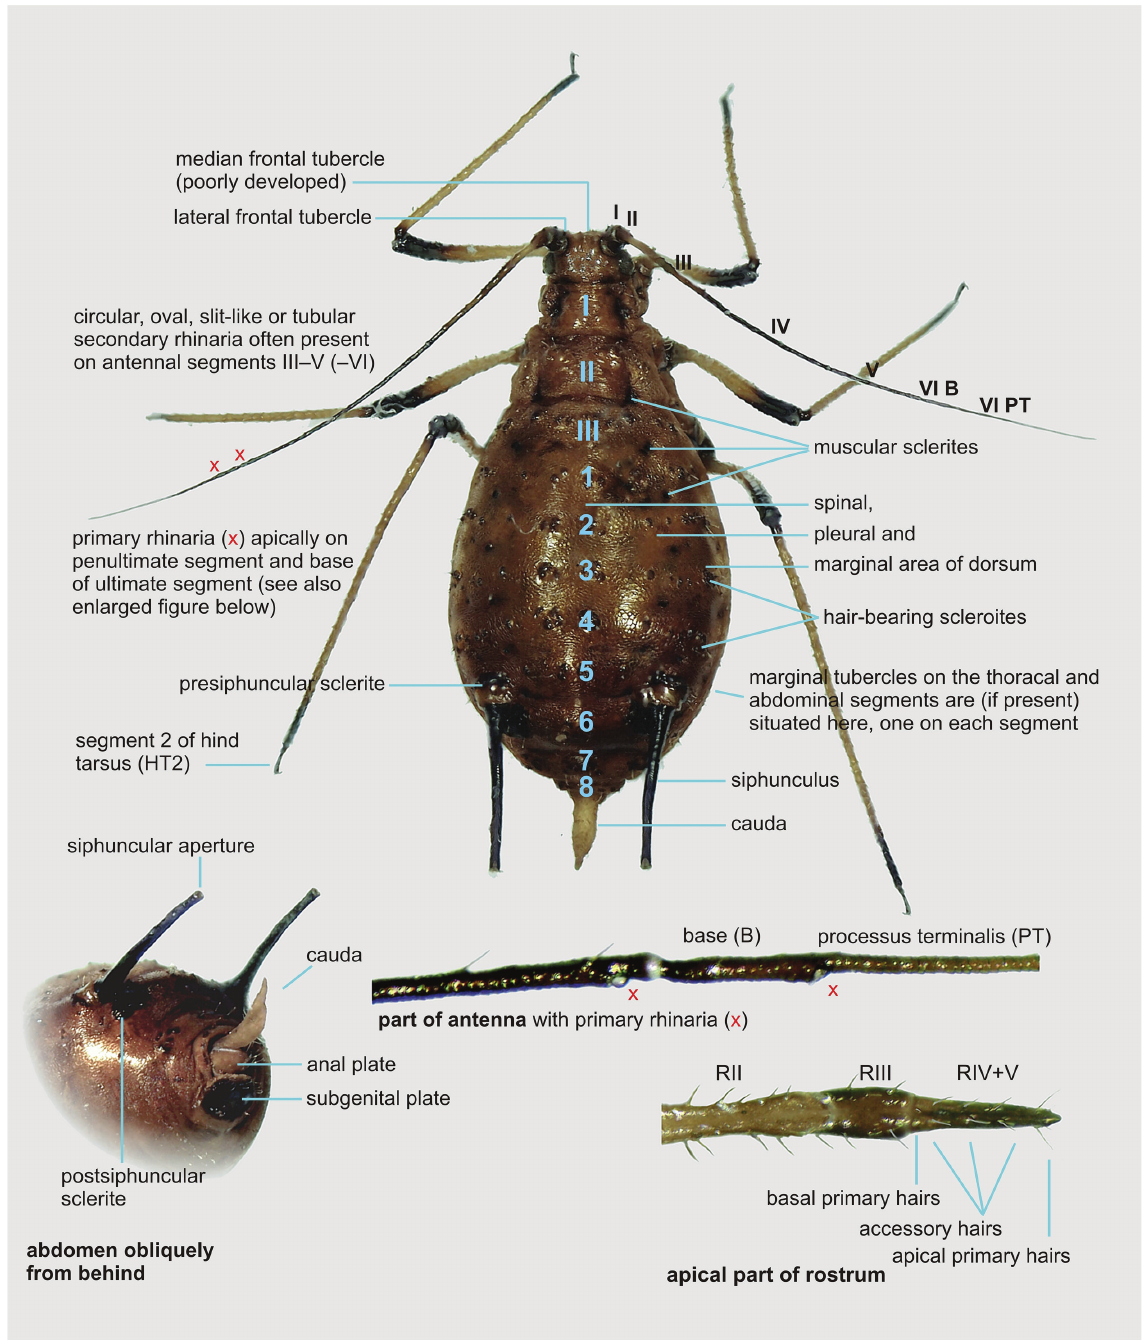
Fig. 6. Often used morphological terms ( Uroleucon cirsii (linnaeus, 1758), freeze-dried